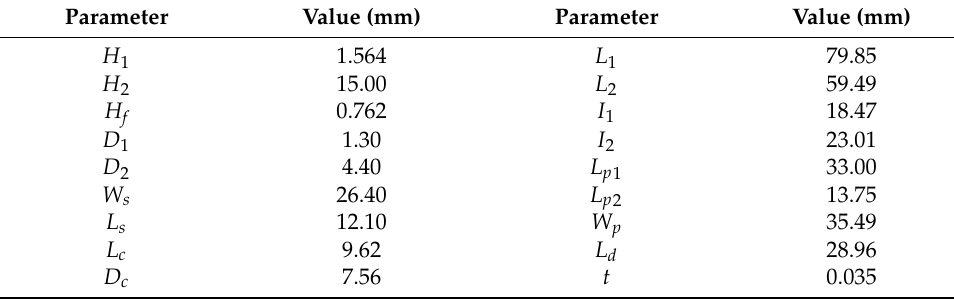
Figure 2. Antenna geometry. ( a ) Parasitic patch; ( b ) Main patch; ( c ) Microstrip BFN line; ( d ) Antenna stack-up. Table 1. Radiating Element Geometrical Parameters.